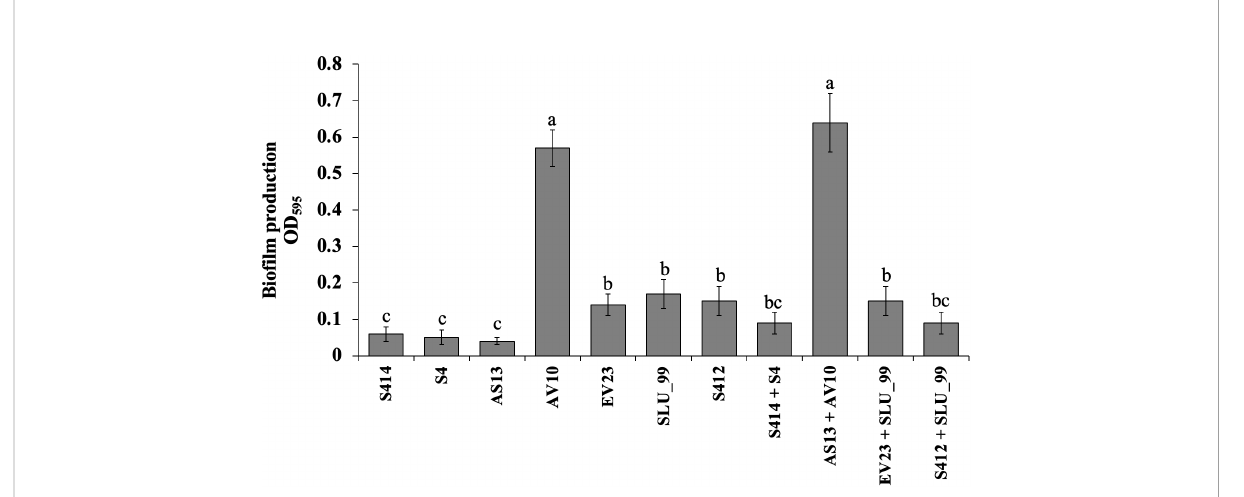
FIGURE 3 Bio fi lm production assay of selected bacterial strains using 96-well polystyrene microplates. Data are the means ± standard deviation (SD) of octuplicates per strain. Mean values with different letters indicates a signi fi cant difference between strains according to Duncan ’ s multiple range test at P >